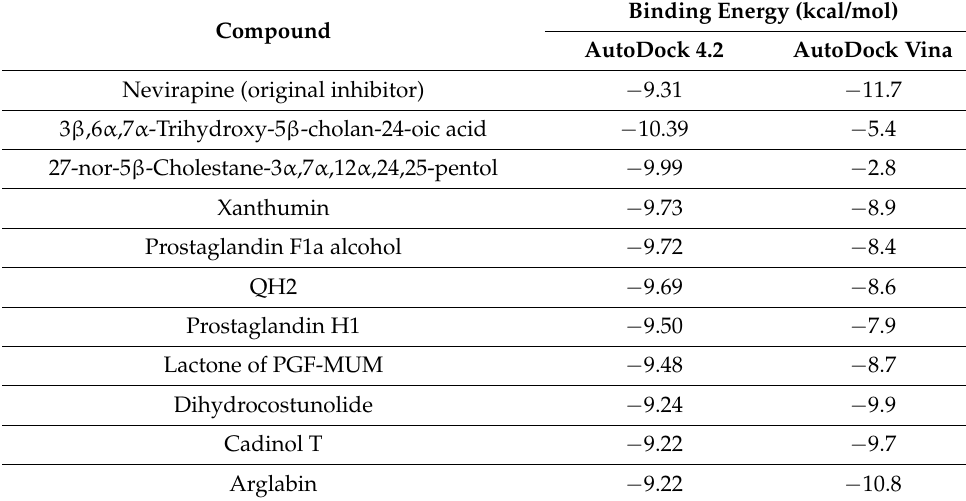
Table 3. Top 10 molecular docking results of CA-identified compounds at the DNA polymerase active site of HIV-1 RT. Binding Energy (kcal/mol) Compound AutoDock 4.2 AutoDock Vina Nevirapine (original